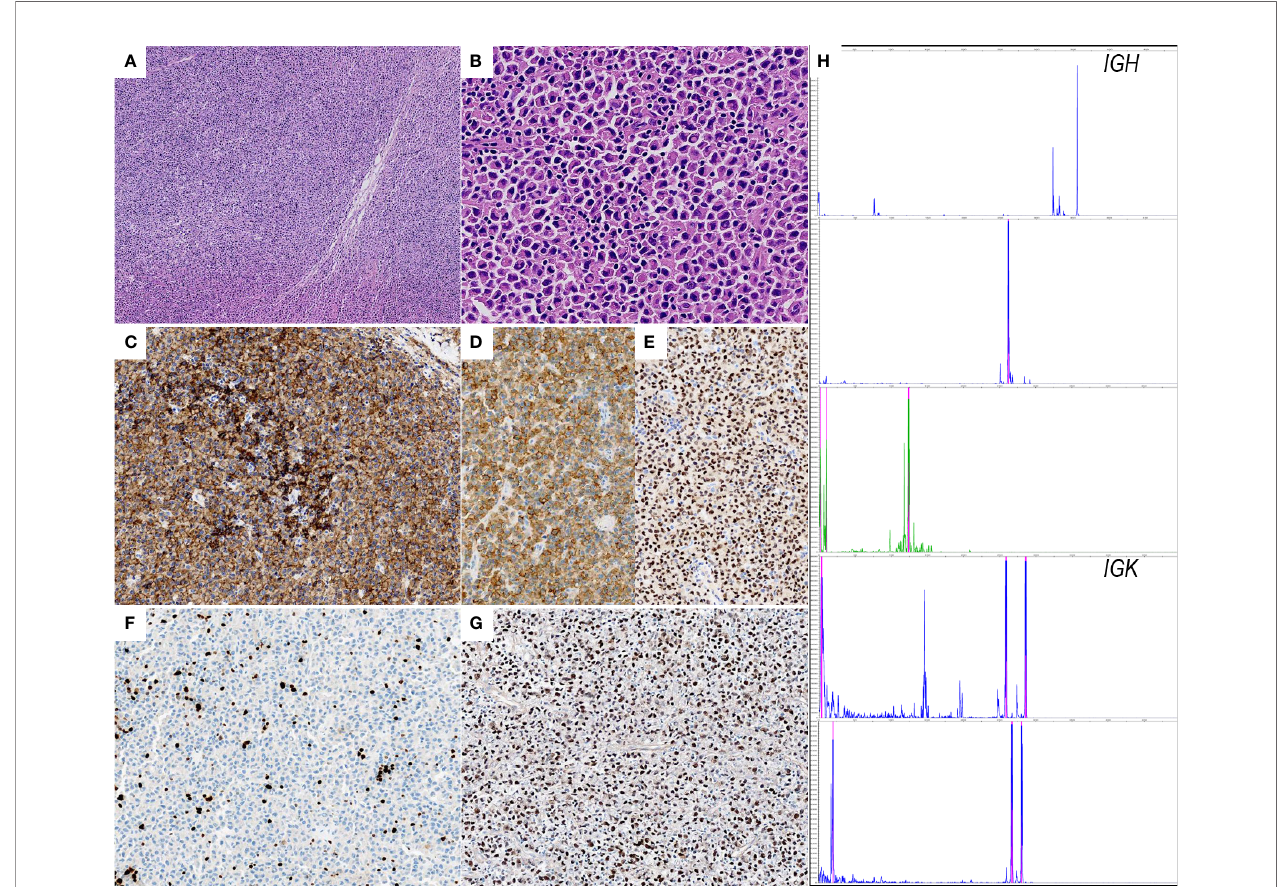
FIGURE 1 | Histopathological features of EBV+ EMZL. (A) Hematoxylin and eosin staining of the excisional tumor biopsy displays dense in fi ltrate of small to medium-sized lymphoplasmacytic cells with a vaguely nodular arrangement; (B) the higher magni fi cation shows classic plasmacytoid cytomorphology with Dutcher bodies; (C) CD20 is positive in neoplastic cells. Note that the CD20 staining intensity is clearly lower in plasmacytoid cells than in lymphoid cells; (D, E) CD38 and MUM1 are strongly positive con fi rming the plasmacytic differentiation; (F) Ki-67 immunostaining demonstrates scattered positivity in the tumor cells, indicating low proliferative activity; (G) the neoplastic cells are uniformly and strongly positive for EBER. (H) Electropherograms reveal monoclonal peaks in IGH and IGK framework